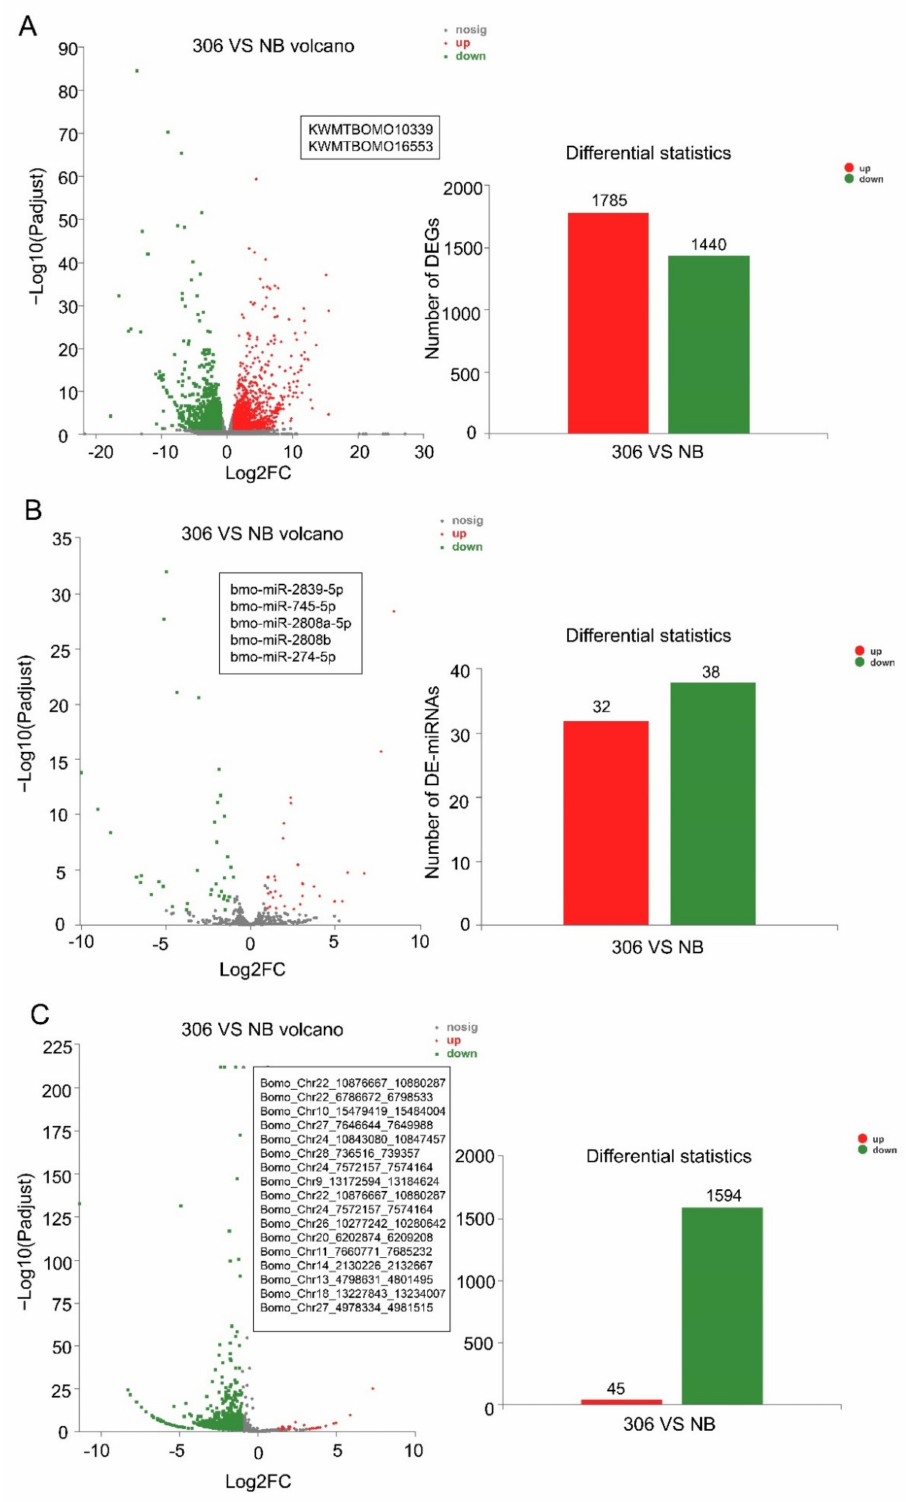
Figure 2. The differential expression analysis of DEGs, DE-miRNAs, and DE-circRNAs in the yellow cocoon silkworm NB compared with white cocoon silkworm 306. ( A ): The volcano map analysis of DEGs; ( B ): The volcano map analysis of DE-miRNAs; ( C ): The volcano map analysis of DE-circRNAs; red dots represent up-regulated differentially expressed profiles, and the green dots represent down- regulated differentially expressed